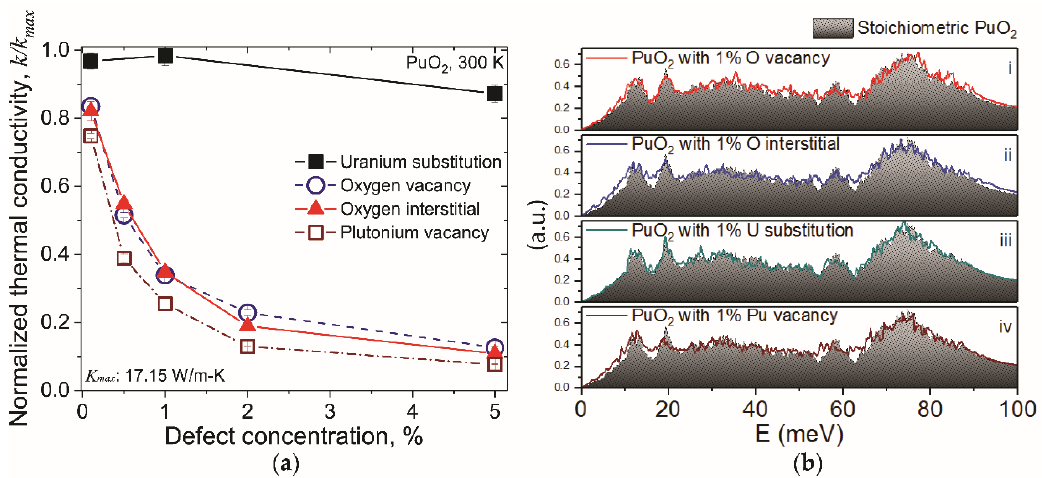
Figure 6. ( a ) The comparison between the effects of different point defects on the thermal conductivity of PuO 2 ( N x = 100). Thermal conductivities are normalized by the thermal conductivity of the stoichiometric PuO 2 ( K max = 17.15 W/m-K). ( b ) Phonon density of states (PDOS) as a function of phonon energy for PuO 2 with different point defects.